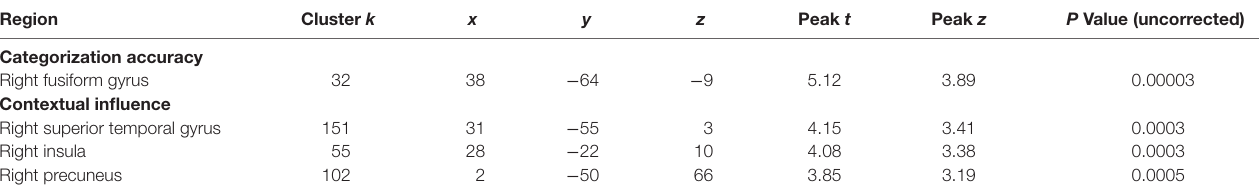
TABLE 6 | Significant brain-behavior associations in NOs. Region Cluster k x y z Peak t Peak z P Value (uncorrected) Categorization accuracy Right fusiform